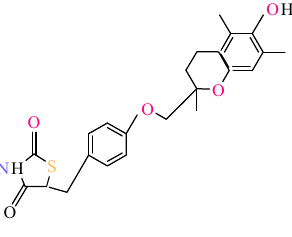
Figure 4: The chemical structure of troglitazone.